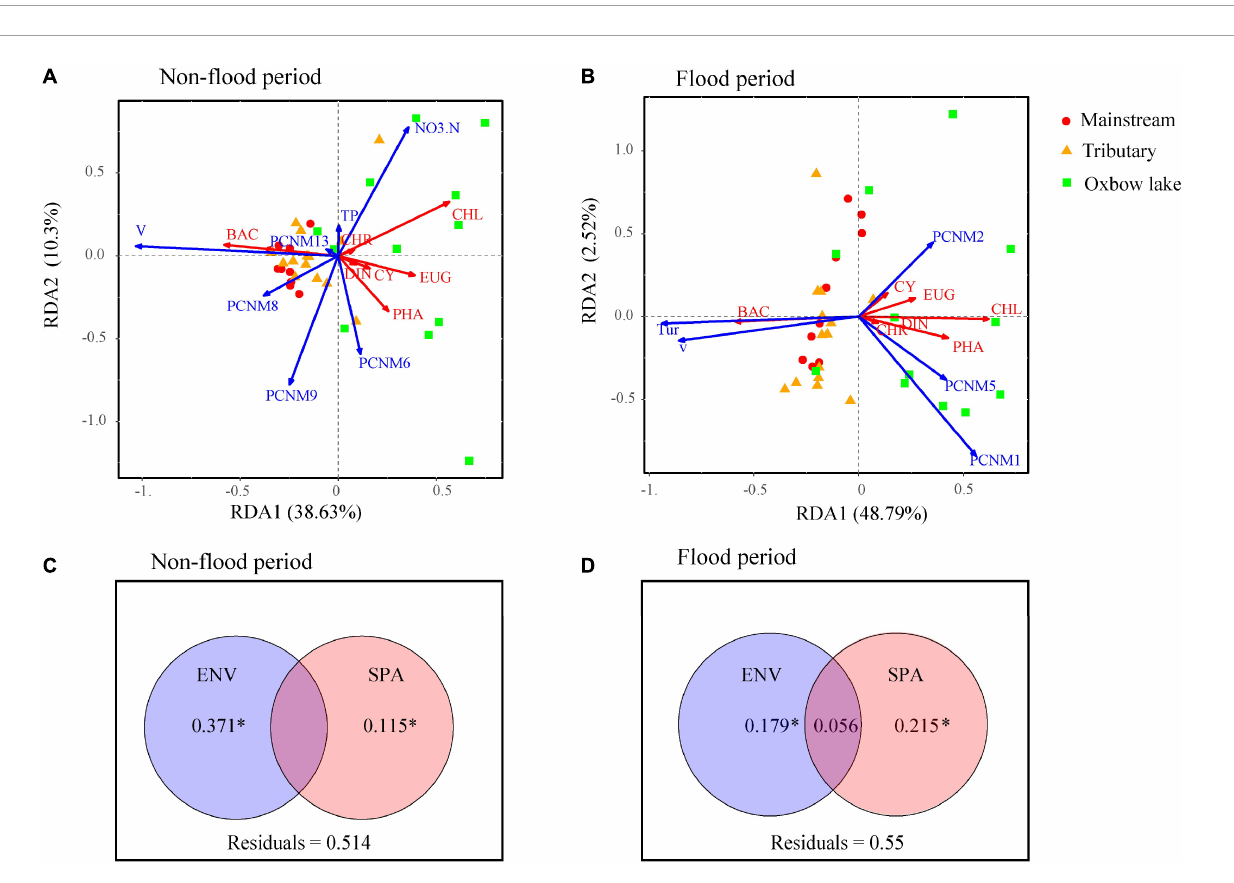
FIGURE6 The relative contribution of local environmental (ENV) and spatial (SPA) variables to the variation of phytoplankton community dynamics (at phyla level) in the river-oxbow lake system of the White River Basin during the (A,C) non-flood and (B,D) flood periods. CYA, Cyanophyta; CHL, Chlorophyta; BAC, Bacillariophyta; EUG, Euglenophyta; CRY, Cryptophyta; CHR, Chrysophyta; EUG, Euglenophyta. Adjusted R 2 values are shown. * P < 0.05 based on 999